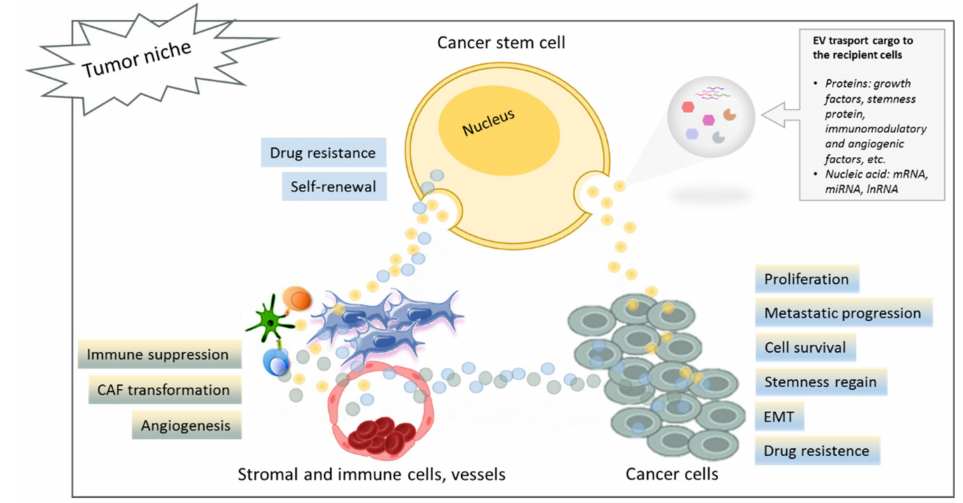
Figure 1. Schematic representation of the communication between CSCs and tumor niche showing activated mechanisms induced by the transfer of EV content to the recipient cells. Abbreviations: CAF, cancer-associated fibroblast; EMT, epithelial–mesenchymal transition.